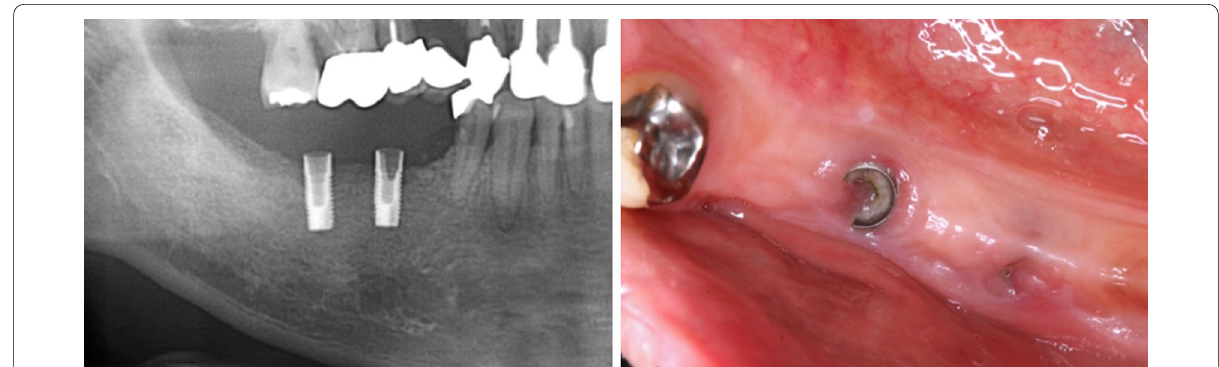
Fig. 3 Fracture in neck part of